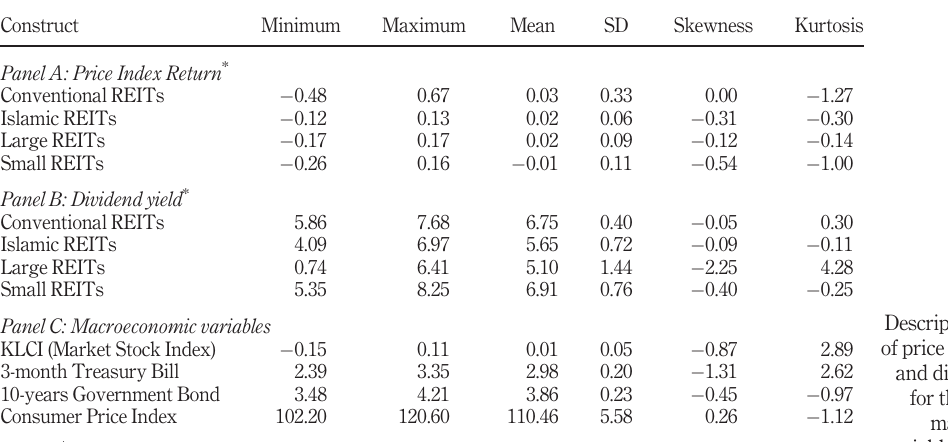
of price index returns and dividend yields for the REITs and macroeconomic variables selected for